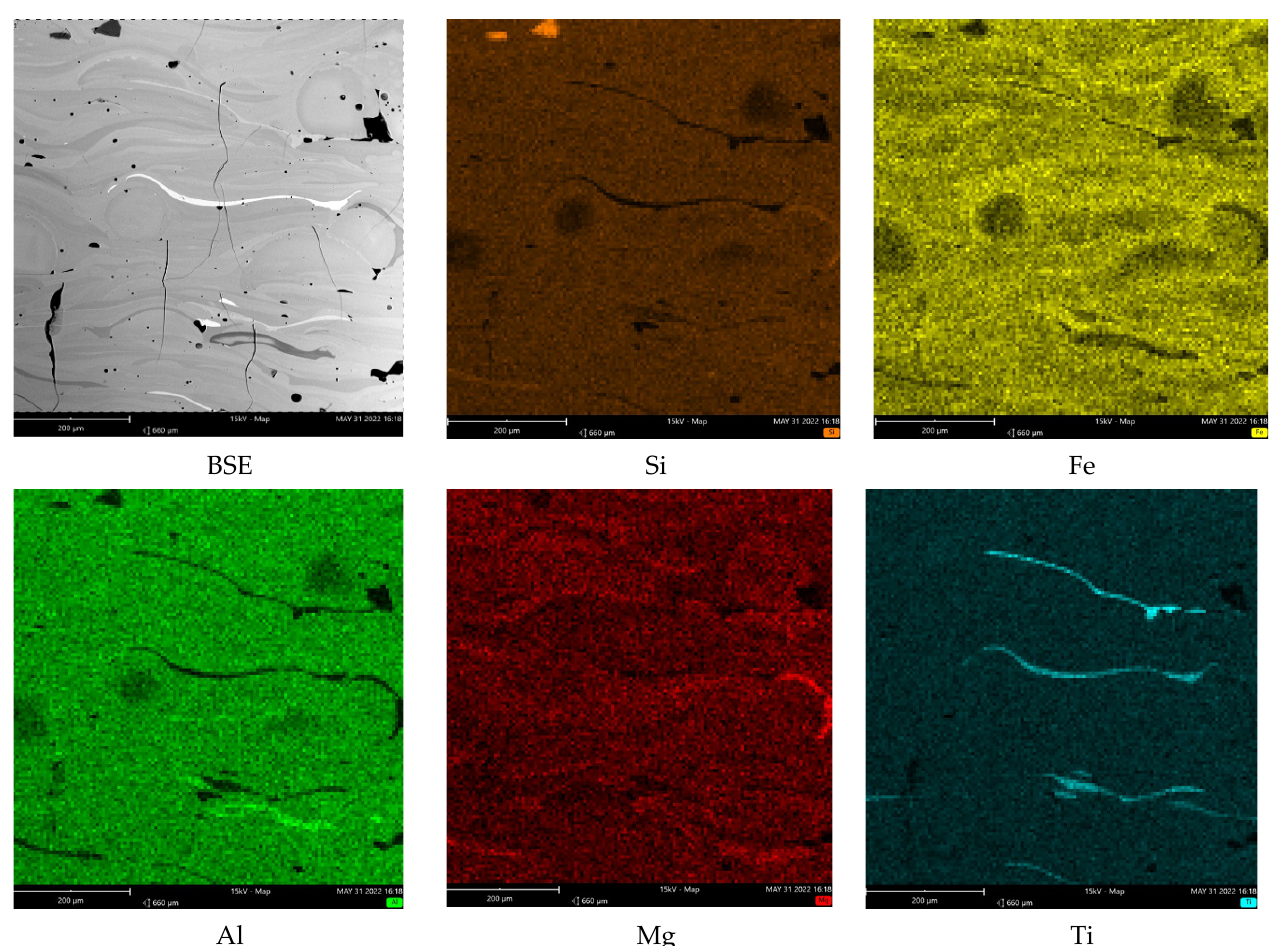
Figure 5. Element mapping of the sample GBM470, polished cross section.